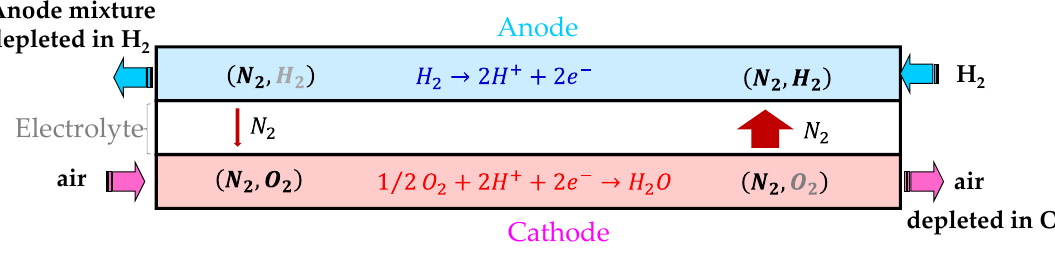
Figure 17. Anode nitrogen stratification without recirculation for partial pressure homogenization.